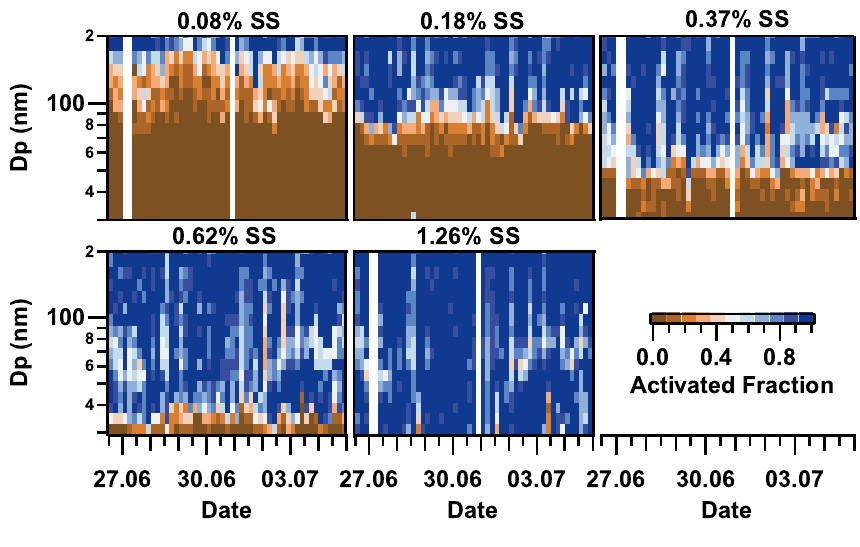
Fig. 13. Time series of F A (S,D 0 ) at each of the 5 supersaturations during the MAP